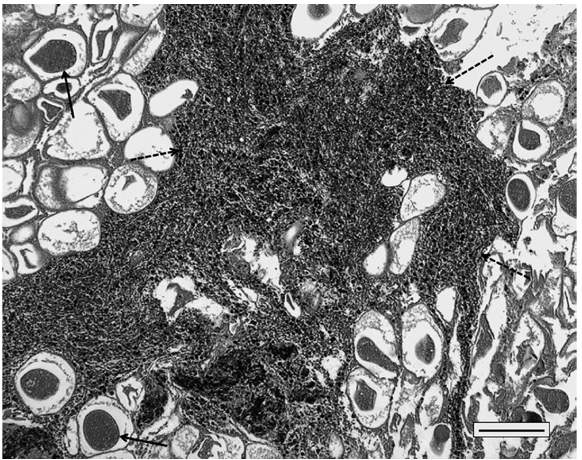
Fig. 6. – Optical micrographs of a ripe oocyte with a nucleus (nc) and a nucleolus (nl) and its two parts: pars granulosa (pg) and pars fibrosa (pf). Scale bars are 30